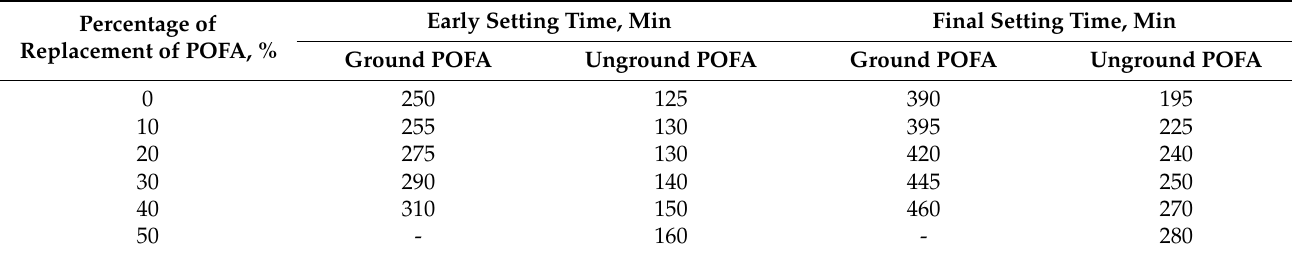
Table 8. POFA concrete times of setting